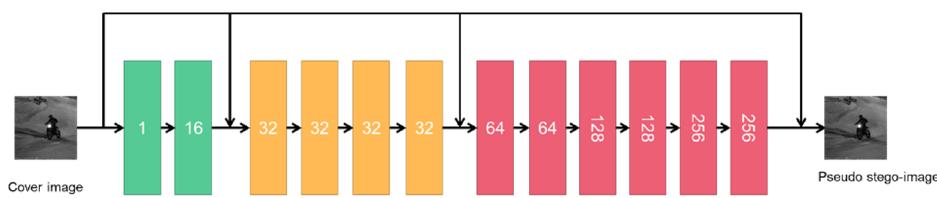
Figure 4. Structure of the RES generator.